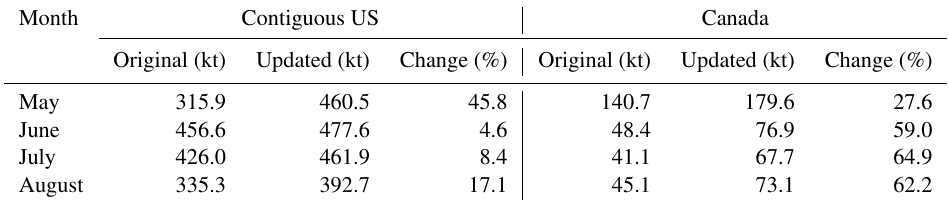
Table 2. Total monthly ammonia emissions (in kilotonnes) for the original and updated sets of emissions for the contiguous US and Canada. Month Contiguous